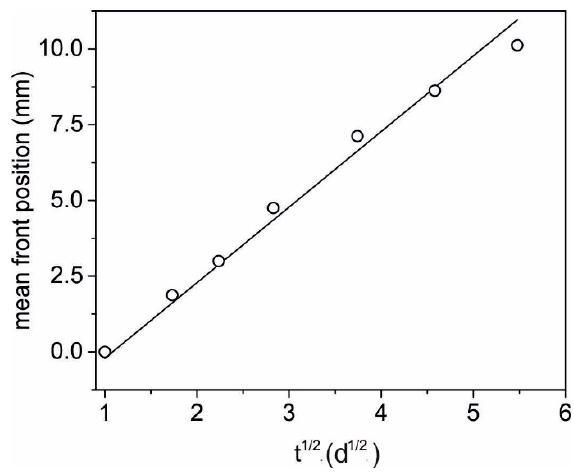
Figure 8. Graph of the advancement of the precipitation front as function of time.